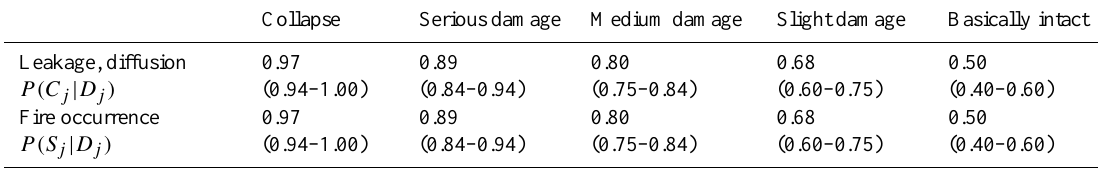
Table 3. Probability of leakage, diffusion, and fire occurrence of inflammable material.